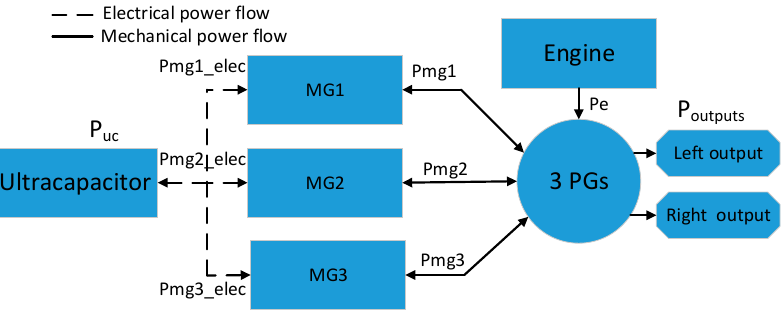
Figure 13. Power flow in the powertrain.